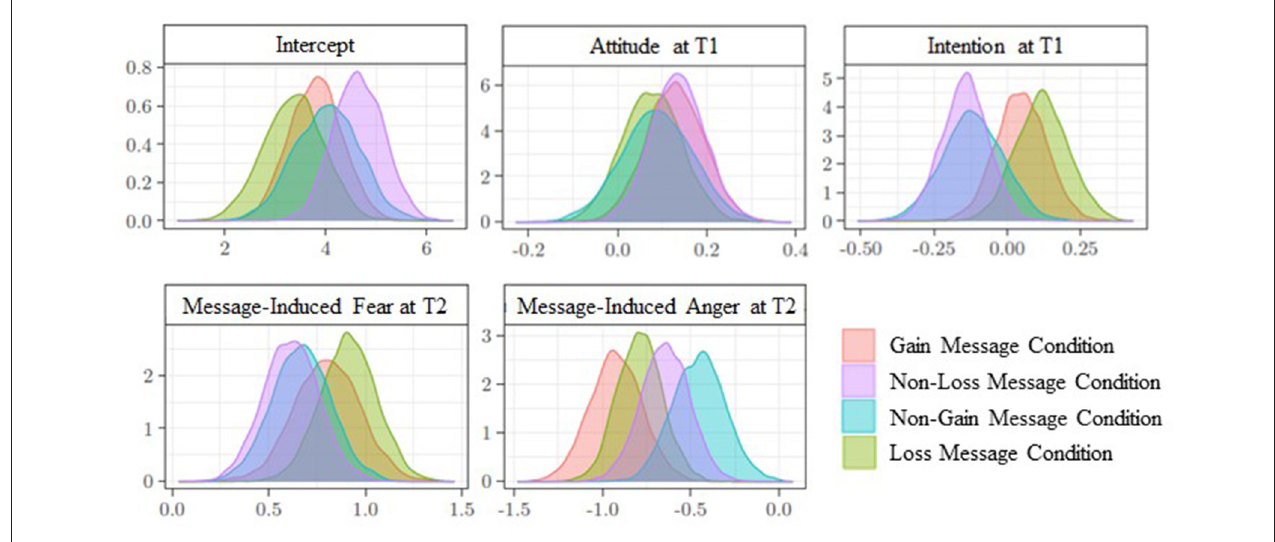
FIGURE 2 | Systematic processing at time 2. Posterior distributions of the parameters associated with predictors, according to message condition.